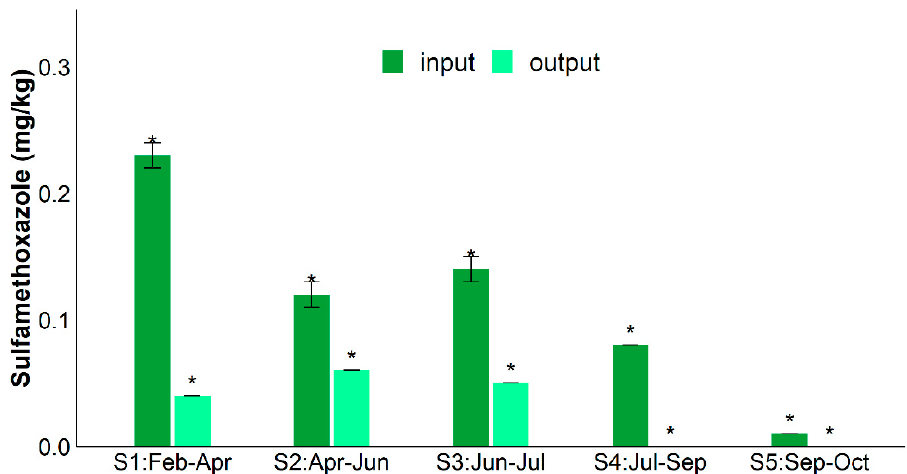
Figure 1. Sulfamethoxazole concentrations (mg/kg) in input and output samples collected during 2019 (S1: In Feb -Out Apr ; S2: In Apr– Out Jun ; S3: In Jun– Out Jul ; S4: In Jul– Out Sep ; S5: In Sep– Out Oct ). The significant differences ( t -test, p < 0.05) are marked with *.